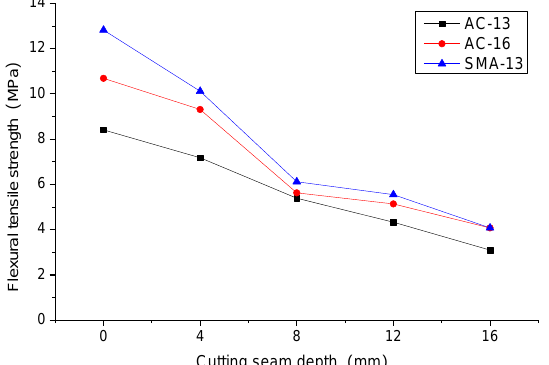
Figure 9. Flexural strength of asphalt mixtures at different notch depths.